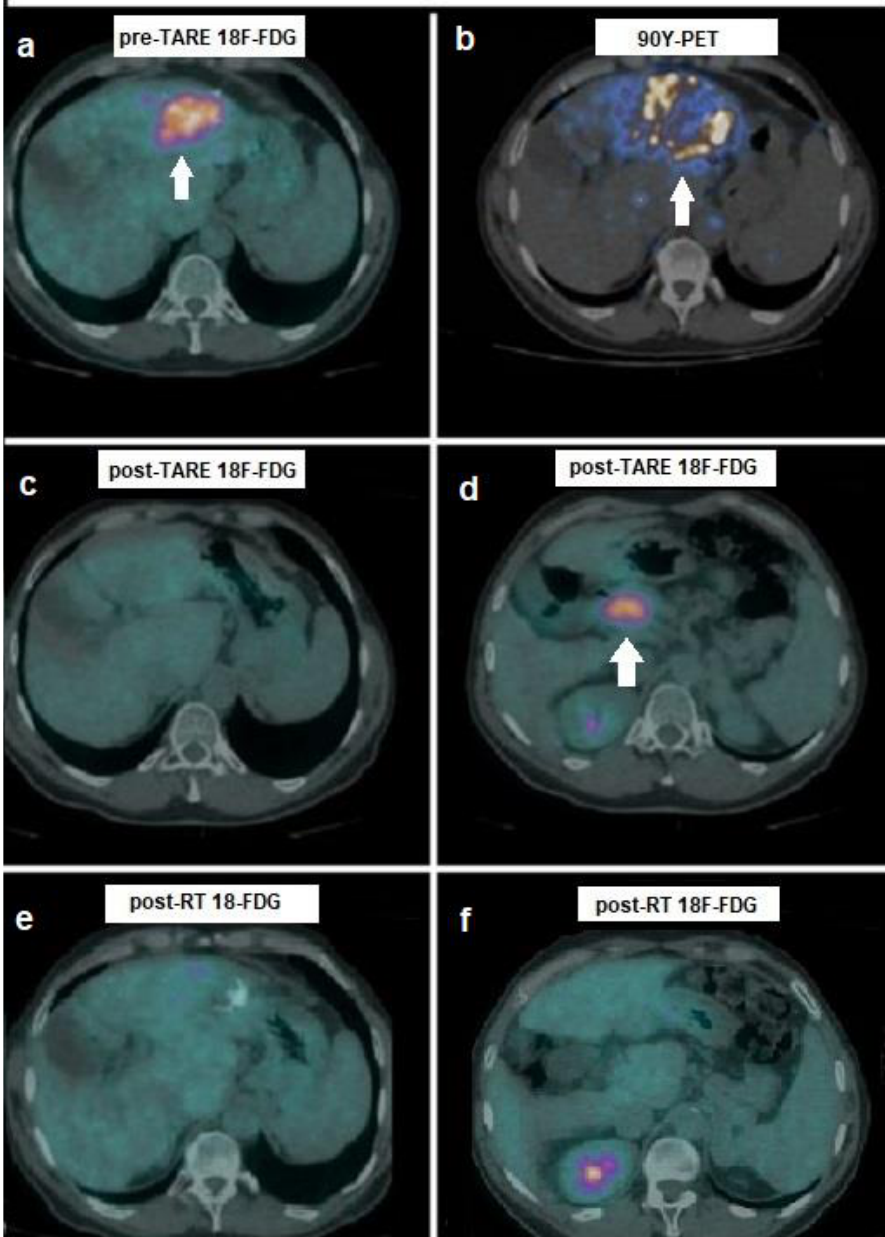
Figure 4. A 51-year-old affected by HCV-related cirrhosis and HCC in the left hepatic lobe, with portal vein invasion, progressive during systemic therapy with sorafenib. On pre-treatment exam- ination, HCC resulted 18 F-FCH-negative, but ( a ) intensely positive on 18 F-FDG PET/CT (arrow, SUVmax 17.7). ( b ) After selective catheterization of HCC’s arterial feeder, he was administered with 90 Y-microspheres: 90 Y-PET showed a peripheral pattern of accumulation with respect to HCC lesion (arrow). At 8-weeks post-treatment 18 F-FDG PET/CT, a complete regression of HCC in the left lobe was evident ( c ), although the onset of an intensely hypermetabolic celiac lymph adenopathy was detected (( d ), arrow). Therapeutic decision was stereotactic RT on the 18 F-FDG-positive metastasis. On follow-up 18 F-FDG PET/CT carried out at 2 months after RT, complete metabolic response was registered both in the hepatic lesion ( e ) and in nodal metastasis ( f ). Overall survival resulted in 36